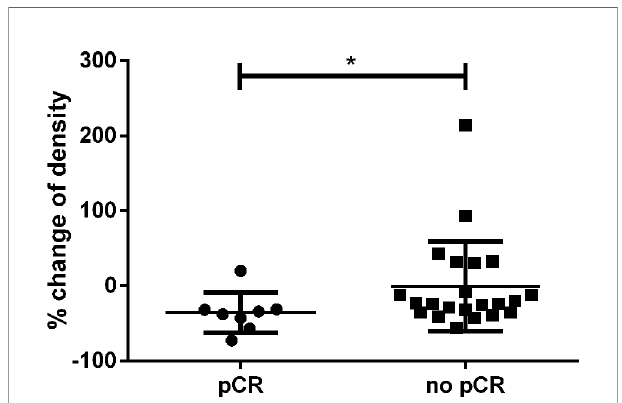
FIGURE 4 | Relative change of CT-based density in percent according to the initially measured HU. Patients with pCR had a signi fi cantly greater decline than patients with residual tumor cells (p=0.030). * is a symbol for signi fi cant differences.